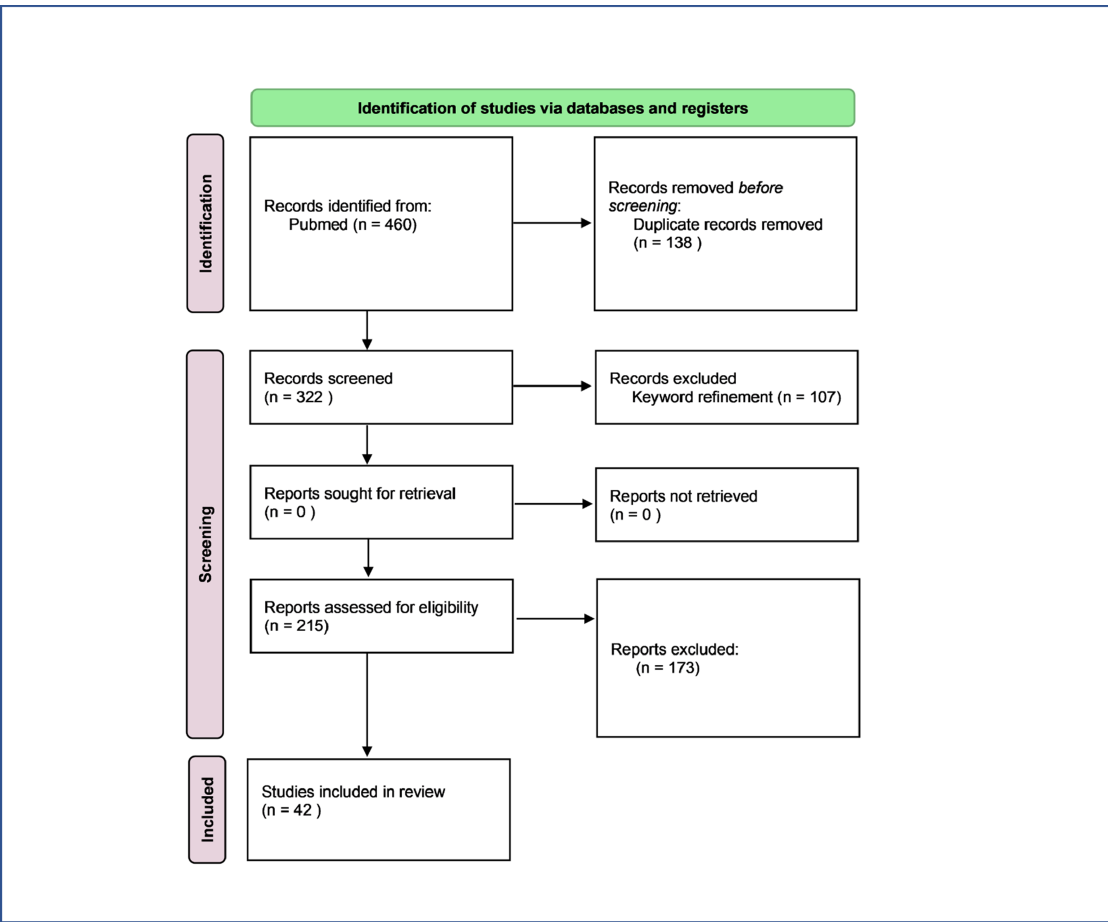
Figure 2. PRISMA flow diagram adapted from the study by Page et al. [38].